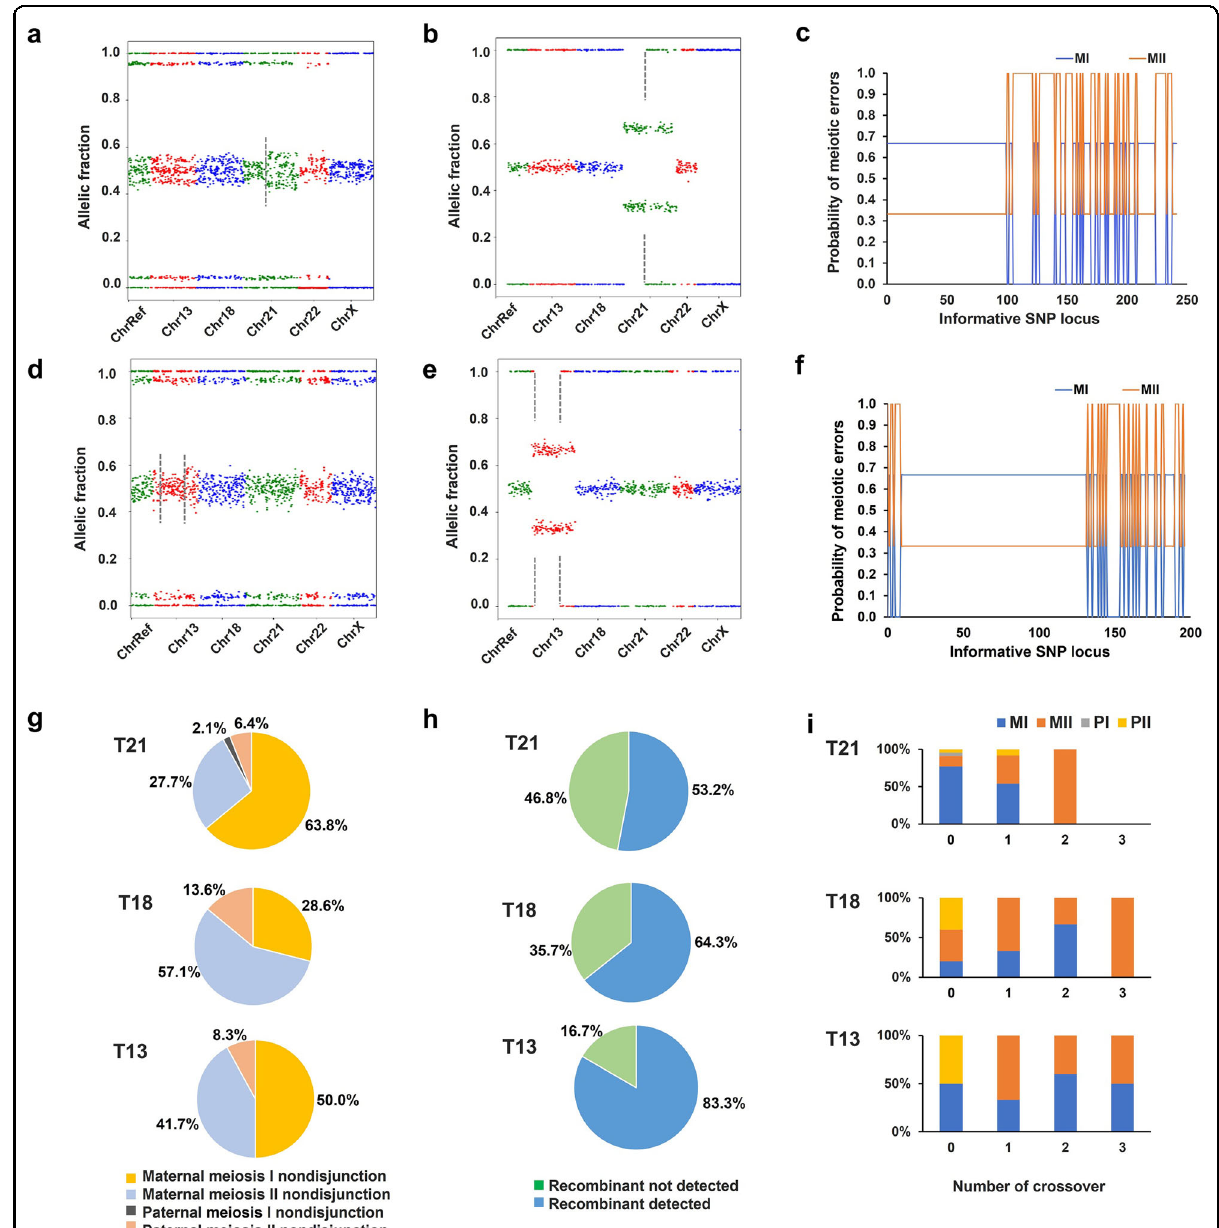
Fig. 4 The fetal cfDNA study reveals parental and meiotic origin of NDJ and homologous recombination associated with aneuploidy. a – c A T21 case using matched maternal and fetal mixed DNA, which shows homologous recombination. The occurrence of recombinant could be inferred from the presence of two different AF patterns consistent with MI and MII NDJs ( a ). In the respective amniocytes, homozygous SNPs (BBB or AAA) are detected only in the telomeric but not centromeric region of chr21 consistent with the presence of recombinant ( b ). At loci where the mother is heterozygous, fetal homozygosity (AAA or BBB) is consistent with MII NDJ. The probability of meiotic errors for each informative locus is plotted ( c ). When fetal genotype is heterozygous (ABB or AAB), the prior probability for the detectable MI NDJ is 2/3 while that for MII NDJ is 1/3 assuming an equal incidence in MI and MII NDJs. The dashed lines indicate the transition of MI and MII SNP patterns suggesting a crossover. d – f The cfDNA collected from a pregnant woman carrying a T13 fetus shows the recombinant with the respective fetal genomic DNA SNP pattern ( e ) and probability of meiotic errors ( f ). The dashed lines show where transition of MI and MII SNP patterns occurs indicating two crossover events. g Percentages of different types of meiotic errors detected. h Percentages of aneuploidy cases with and without detectable recombinants. i The number of crossovers associated with different types of meiosis NDJ. MI maternal meiosis I, MII maternal meiosis II, PI paternal meiosis I, PII paternal meiosis II, NDJ